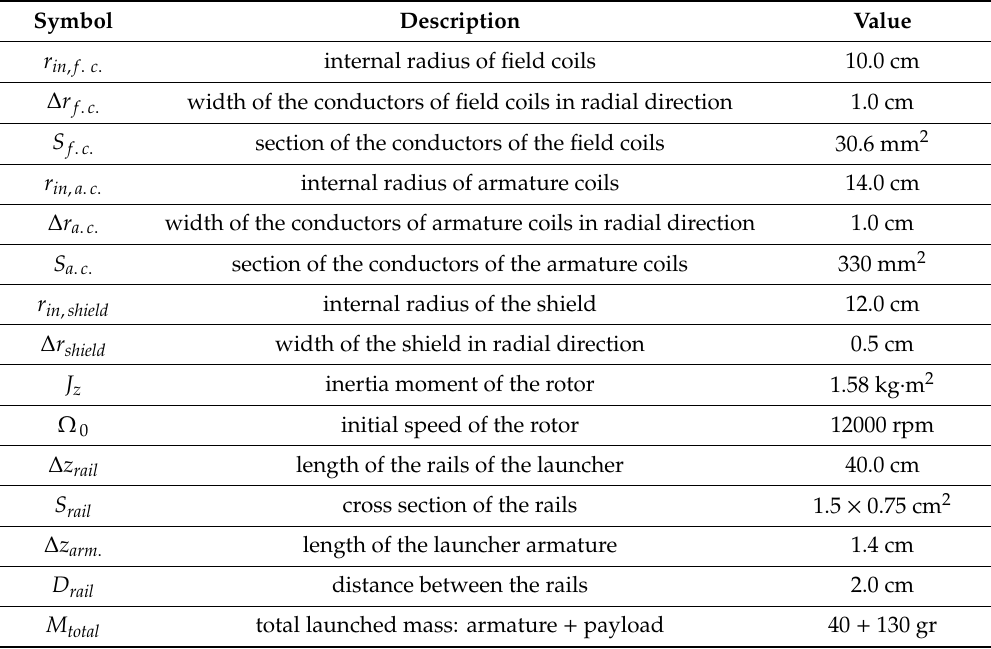
Figure 5. A sketch a rail launcher. The inset put into evidence the cross section of half of the upper rail. The labelled rectangles represent the cross section of the inner layer of the elementary volumes, i.e., those involved in the sliding contacts with the armature. Table 2. Description of the devices.